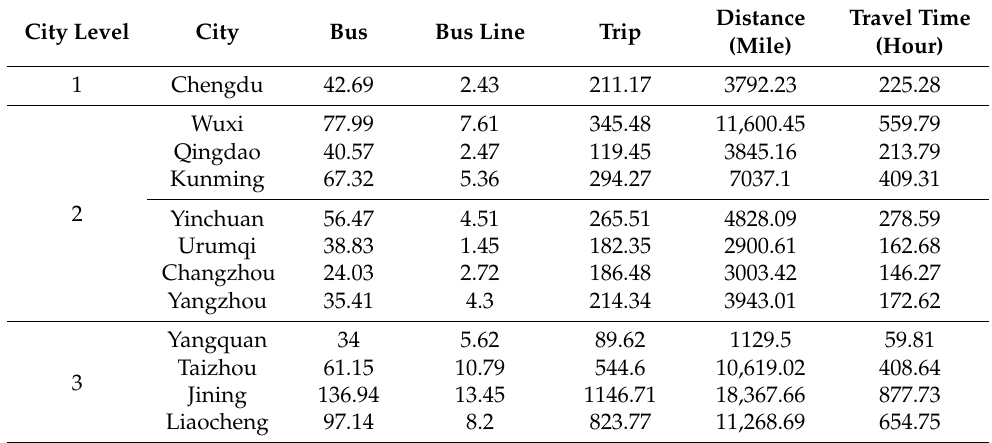
Table 5. Dispatcher data per